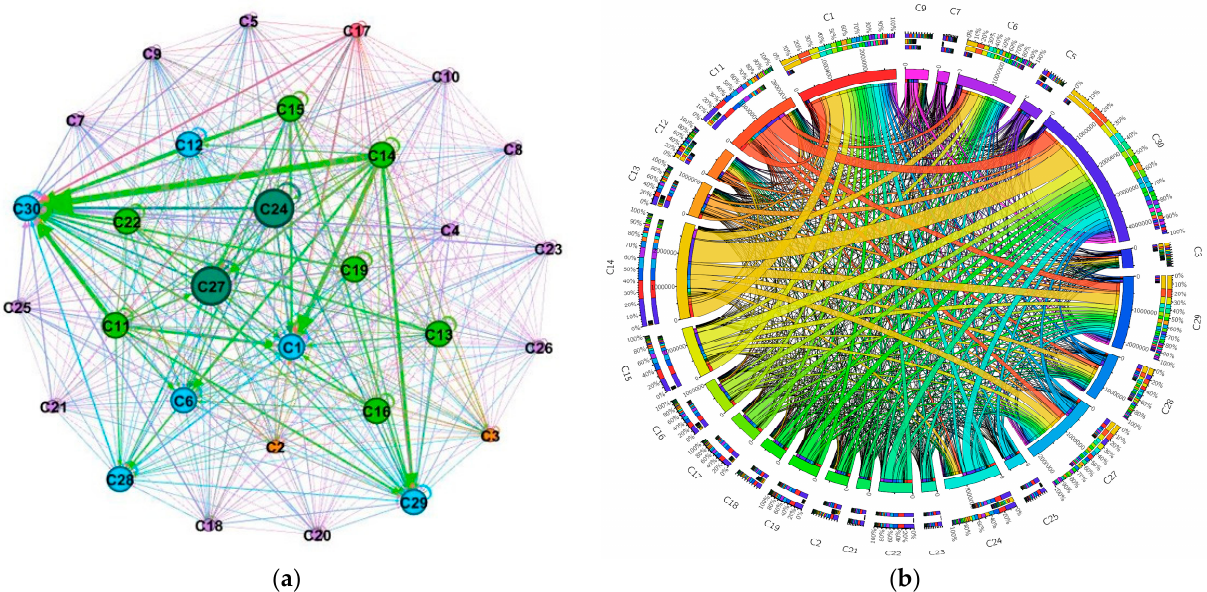
Figure 8. Graph of Embodied carbon emissions flows between industry sectors in Heilongjiang. ( a )